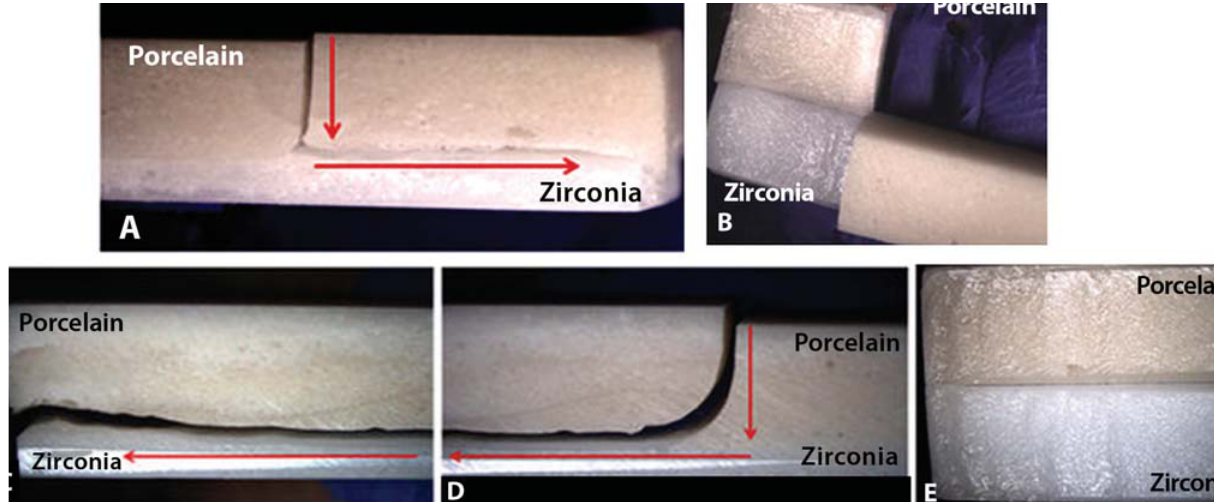
Figure 4- (cid:3)(cid:21)(cid:16)(cid:80)(cid:80)(cid:16)(cid:87)(cid:75)(cid:76)(cid:70)(cid:78)(cid:3)(cid:11)(cid:36)(cid:30)(cid:3)(cid:37)(cid:12)(cid:3)(cid:68)(cid:81)(cid:71)(cid:3)(cid:22)(cid:16)(cid:80)(cid:80)(cid:16)(cid:87)(cid:75)(cid:76)(cid:70)(cid:78)(cid:3)(cid:11)(cid:39)(cid:30)(cid:3)(cid:38)(cid:30)(cid:3)(cid:40)(cid:12)(cid:3)(cid:83)(cid:82)(cid:85)(cid:70)(cid:72)(cid:79)(cid:68)(cid:76)(cid:81)(cid:3)(cid:69)(cid:68)(cid:85)(cid:17)(cid:3)(cid:39)(cid:72)(cid:73)(cid:72)(cid:70)(cid:87)(cid:3)(cid:83)(cid:85)(cid:82)(cid:83)(cid:68)(cid:74)(cid:68)(cid:87)(cid:76)(cid:82)(cid:81)(cid:3)(cid:73)(cid:85)(cid:82)(cid:80)(cid:3)(cid:83)(cid:82)(cid:85)(cid:70)(cid:72)(cid:79)(cid:68)(cid:76)(cid:81)(cid:3)(cid:86)(cid:88)(cid:85)(cid:73)(cid:68)(cid:70)(cid:72)(cid:3)(cid:87)(cid:82)(cid:3)(cid:76)(cid:81)(cid:87)(cid:72)(cid:85)(cid:73)(cid:68)(cid:70)(cid:72)(cid:3)(cid:11)(cid:20)(cid:19)(cid:91)(cid:12)(cid:3)(cid:68)(cid:81)(cid:71)(cid:3)